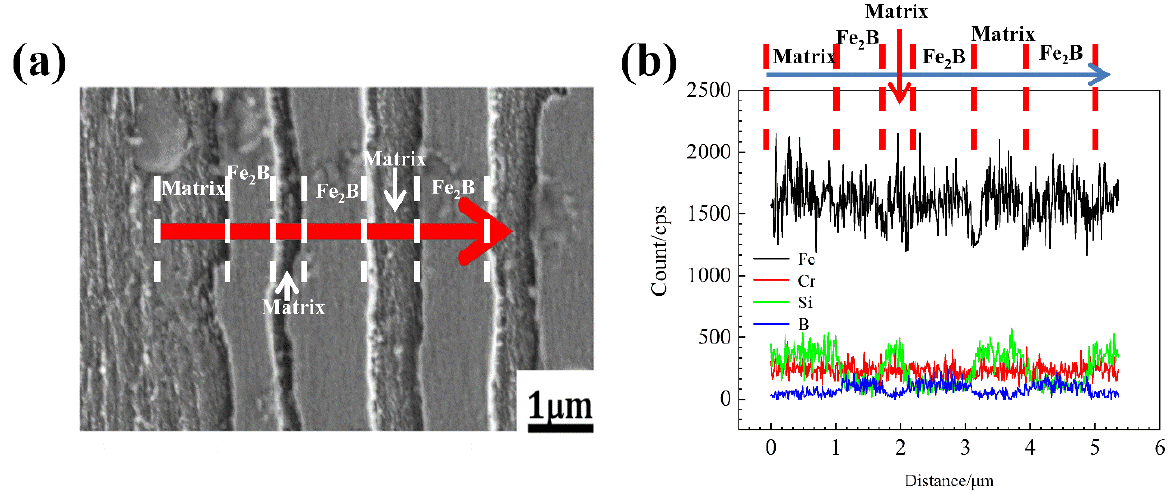
Figure 8. Line scanning analysis of A3 DS Fe-B alloy: ( a ) direction of line scanning, ( b ) peak change of Fe, Cr, Si, and B.